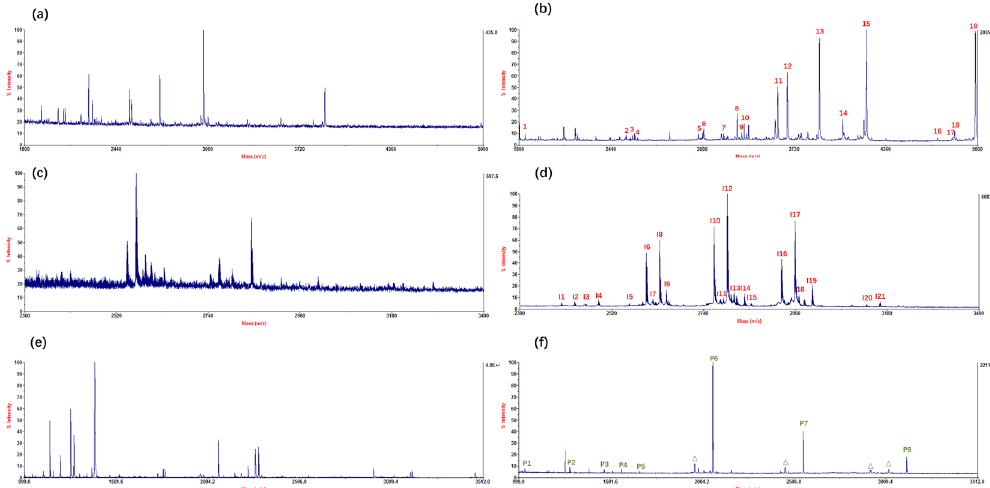
Figure 2. MALDI-TOF mass spectra for the glycopeptide enrichment from 250 fmol/ μ L HRP tryptic digest: ( a ) before enrichment, and ( b ) after treatment; from 1 pmol/ μ L IgG: ( c ) before enrichment, and ( d ) after treatment; from 200 fmol/ μ L β -Casein: ( e ) before enrichment, and ( f ) after treatment, where glycopeptides were marked with Arabic Numerals in red, phosphopeptides were marked with Arabic Numerals in green, and Δ indicates the losses of phosphoric